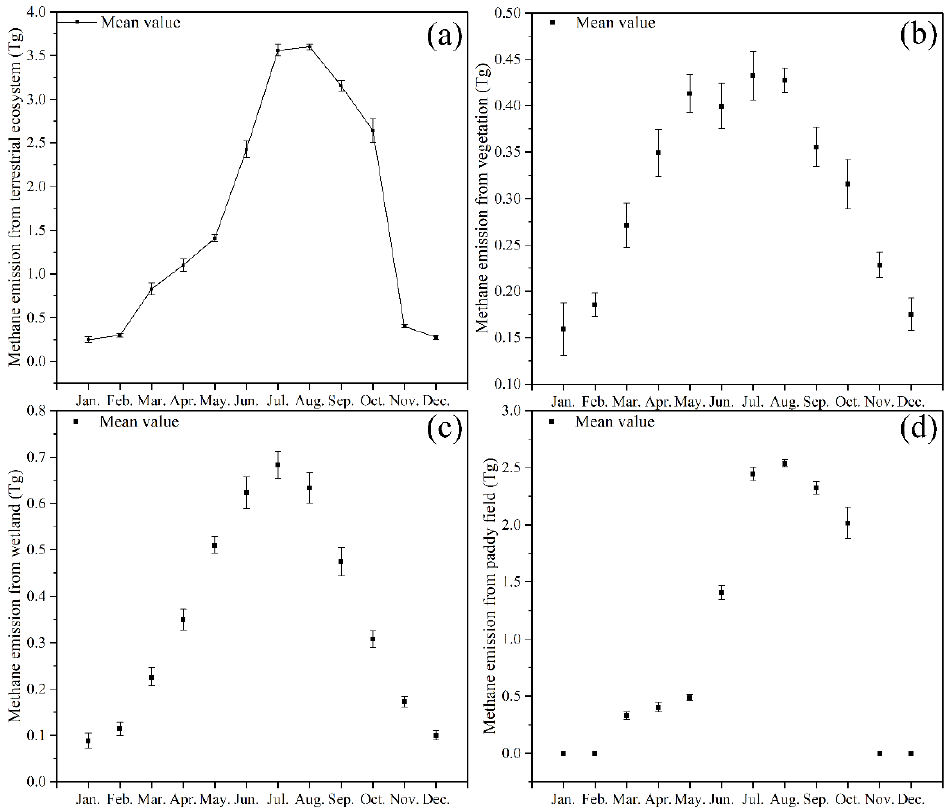
Figure 4. ( a ) Monthly CH 4 emissions from terrestrial ecosystems; ( b ) Monthly CH 4 emissions from vegetation; ( c ) Monthly CH 4 emissions from wetland; ( d ) Monthly CH 4 emissions from paddy fields.